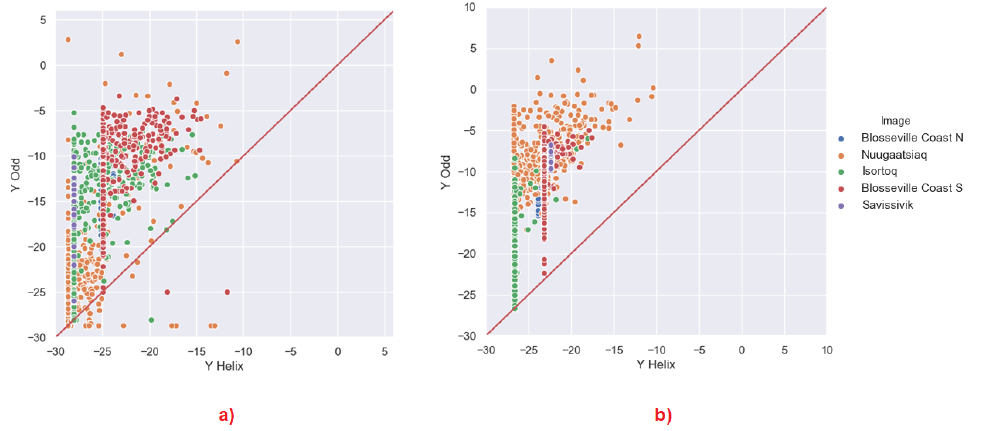
Figure 27. ( a ) Iceberg helix scattering, surface scattering plot in a 5 × 5 window, ( b ) 11 × 11 window. The huge majority of icebergs show surface scattering. Colour legend indicates image. Dots indicate icebergs. All values are in